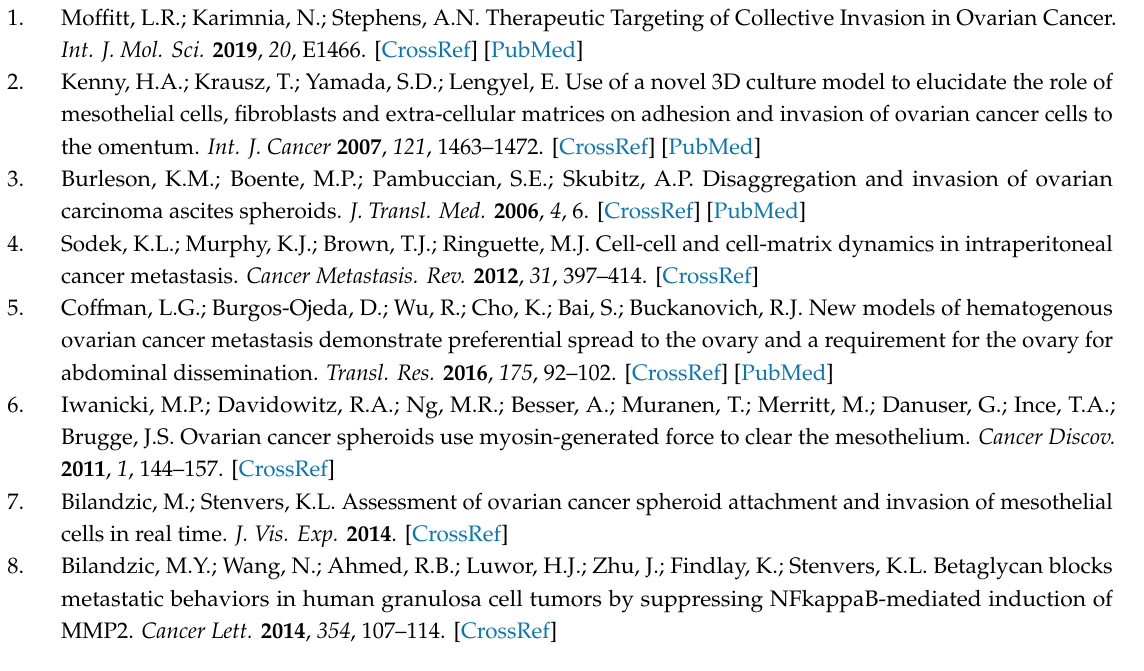
Figure S1: Western Blot screening following CRISPR transfection and selection, Figure S2: KRT14 and H&E staining of USBiomax TMAs, Figure S3: KRT14 antibody specificity on wild type, overexpressing and K14 knockout cells—OVCAR4, Figure S4: xCELLigence Proliferation and invasion—CaOV3, Table S1: MALDI target identification, Table S2: Densitometry assessments for Western blot from figure 3A, Table S3: Western Blot Densitometry, Table S4: Patient sample details for TMA analyses, Table S5: CRISPR sgRNA sequences to target